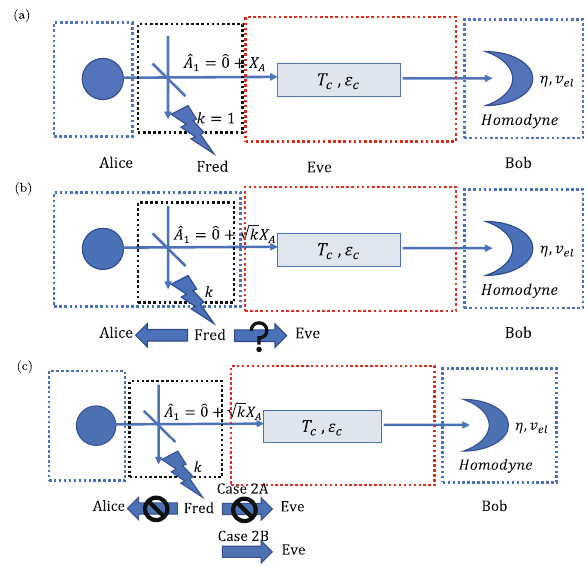
Fig. 1 Practical CV QKD system with different security assump- tions. ( a ) Case (0): ideal CV QKD system (k = 1) ( b ) Case (1): k is disclosed to Alice ( c ) Case (2): k is not disclosed to Alice. Here, practical CV QKD systems can be divided into two cases based on the Alice ’ s information about intensity fl uctuations. One ideal case (0) is added for comparison. In case (0), a CV QKD system does not have any intensity fl uctuations. In case (1), Alice can monitor the intensity fl uctuations. In case (2), Alice cannot monitor the intensity fl uctuations. Depending on whether Eve has intensity fl uctuation information or not, case (2) is divided into two subcases (2A) and (2B). Here, T c and ε c are, respectively, the channel transmittance and excess noise between Alice and Bob. η and v el are the the detection ef fi ciency and electronic noise of the homodyne detector. Here, the symbol “ ? ” in case (1) means that Eve may or may not have access to the intensity fl uctuation information. The No Entry sign in case (2) means that the intensity fl uctuation information will not